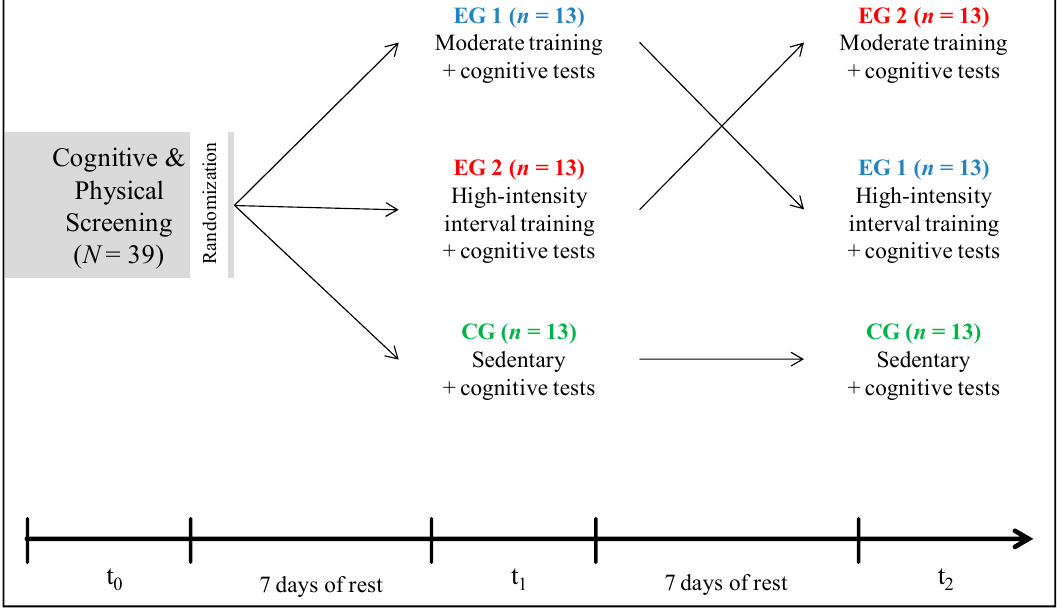
Figure 1. Experimental design. N = 39. Study included three sessions (t0, t1, t2) and three groups: experimental group 1 (EG1, n = 13), experimental group 2 (EG2, n = 13) and control group (CG, n = 13). The experimental groups performed either a single bout of moderate intensity or a high-intensity